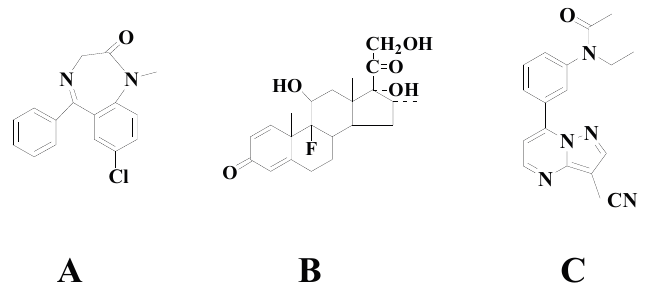
Figure 1. Chemical structures of the analytes: diazepam ( A ), dexamethasone ( B ) and the internal standard (IS) zaleplon ( C